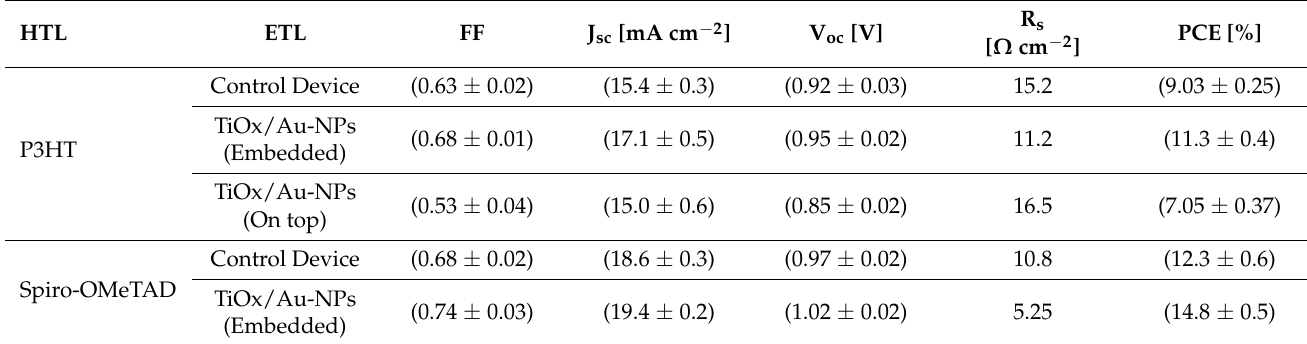
Table 5. Electrical output characteristics of the devices with P3HT and Spiro-OMeTAD as HTLs.